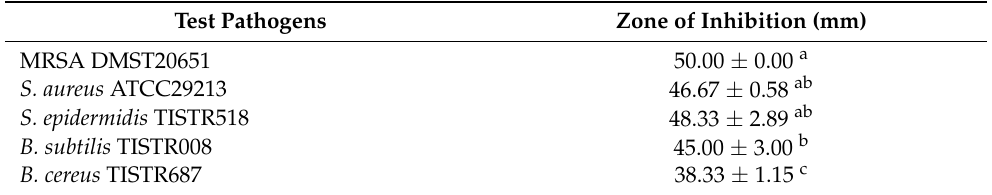
Table 1. Antibacterial activity of Streptomyces sp. PJ85 against test pathogens according to the perpendicular streak method.